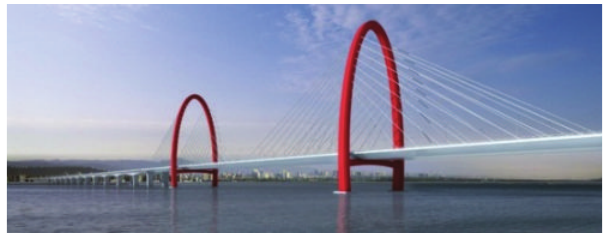
Figure 1: Photograph of Zhijiang